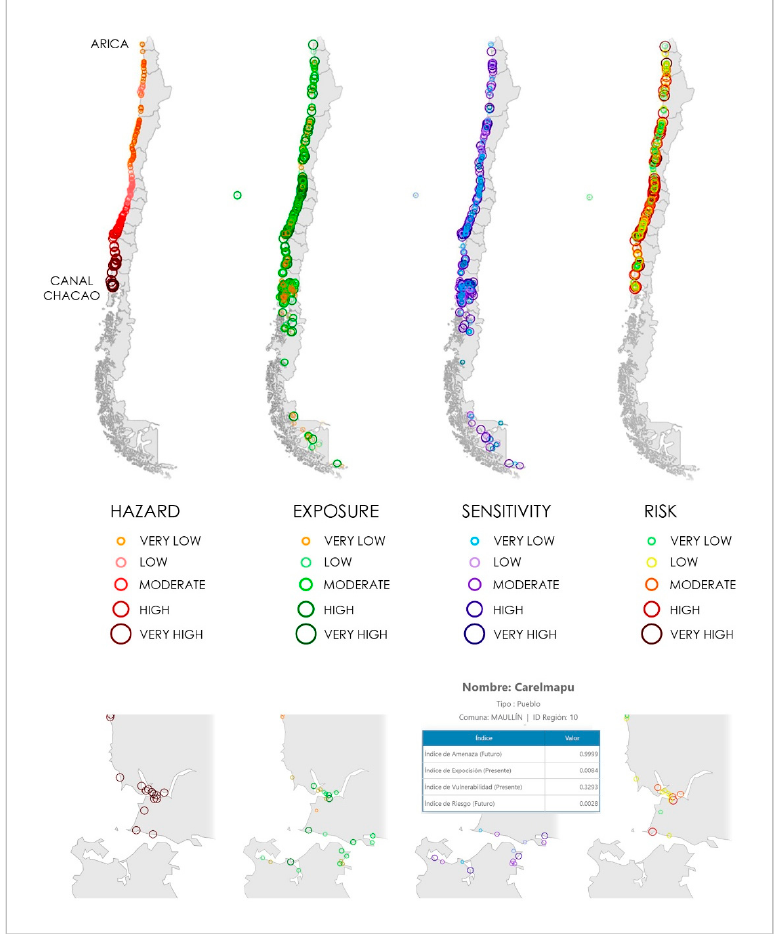
Figure 6. Relative values of the hazard, exposure, sensitivity, and risk of coastal settlements to coastal flooding. Bottom: Zoomed-in view covering Canal Chacao, including indices at Carelmapu (41.745° S–73.705° W). Available at https://arclim.mma.gob.cl/atlas/view/asentamientos_costeros/ (accessed on 12 October 2022).